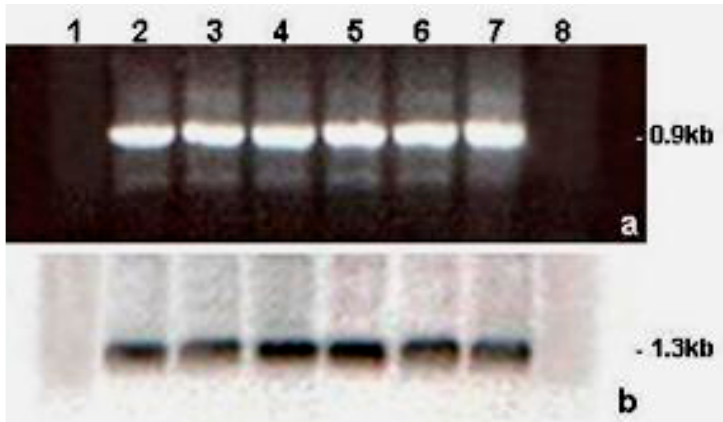
Figure 5. Dhpg expression on sunflower infected tissues. Lanes 1, 2, 3: stem cuts infection, control stems at 7 d, treated stems after 7 and 12 d respectively; lanes 4, 5: control mycelium grown 7 and 12 d respectively; lanes 6, 7, 8: in planta infection, treated stems after 7 and 12 d, control stems at 12 d respectively. a. RT-PCR as in Figure 4a. b . Northern hybridization as in Figure